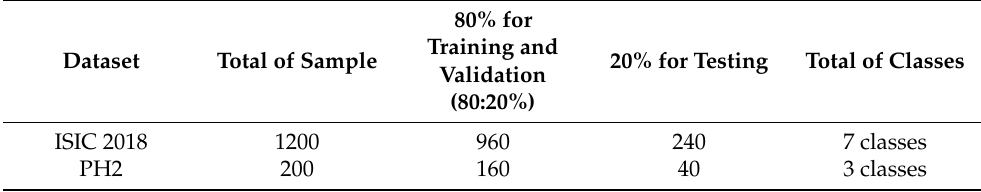
Table 3. Splitting the two data set for training and